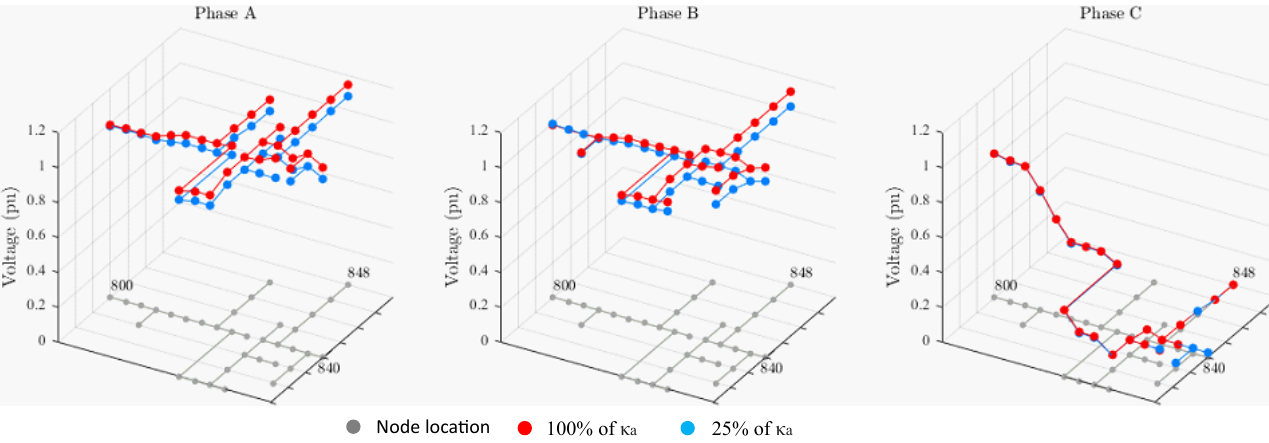
Figure 14. Voltage profile using the proposed method for single-phase fault in phase